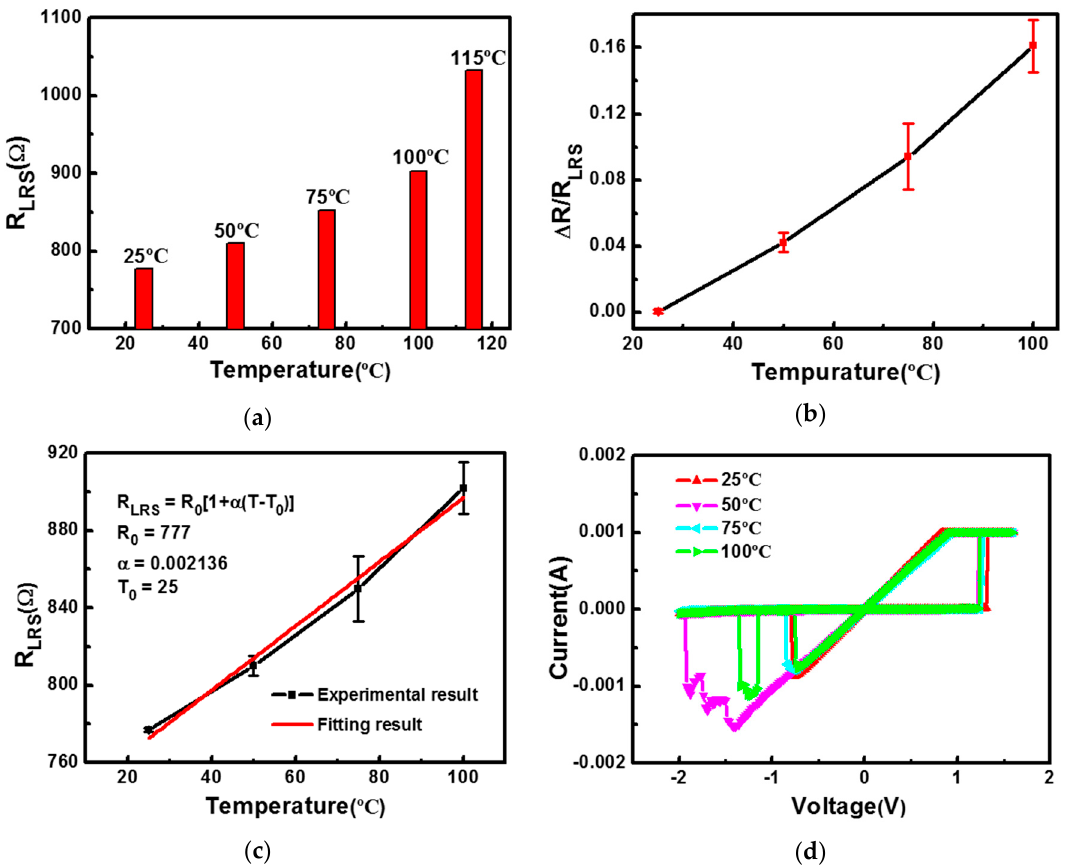
Figure 5. Temperature sensing characteristics of the polymer device; ( a ) Resistance of the low-resistance state (LRS) as a function of temperature ranging from 25 °C to 115 °C; ( b ) Resistance ratio of the LRS versus the temperature ranging from 25 °C to 100 °C; ( c ) The fitting result from the equation; ( d ) The I-V curves of the polymer device at different temperatures.